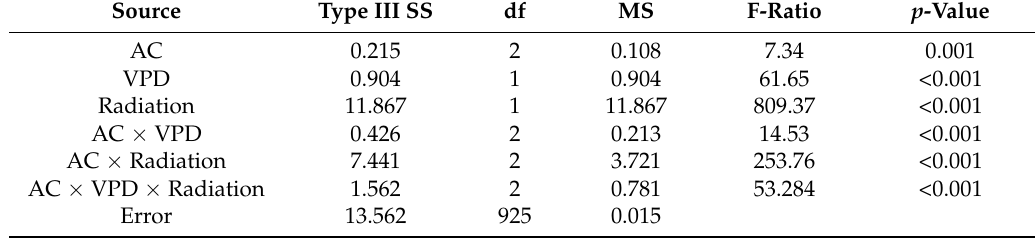
Figure 2. Half hourly sap flux density (SFD) of Fraxinus trees in relation to solar radiation (W/m 2 ) during 26–30 June 2010 (AC1 = low, AC2/3 = moderate, AC 4 = high infestation levels).